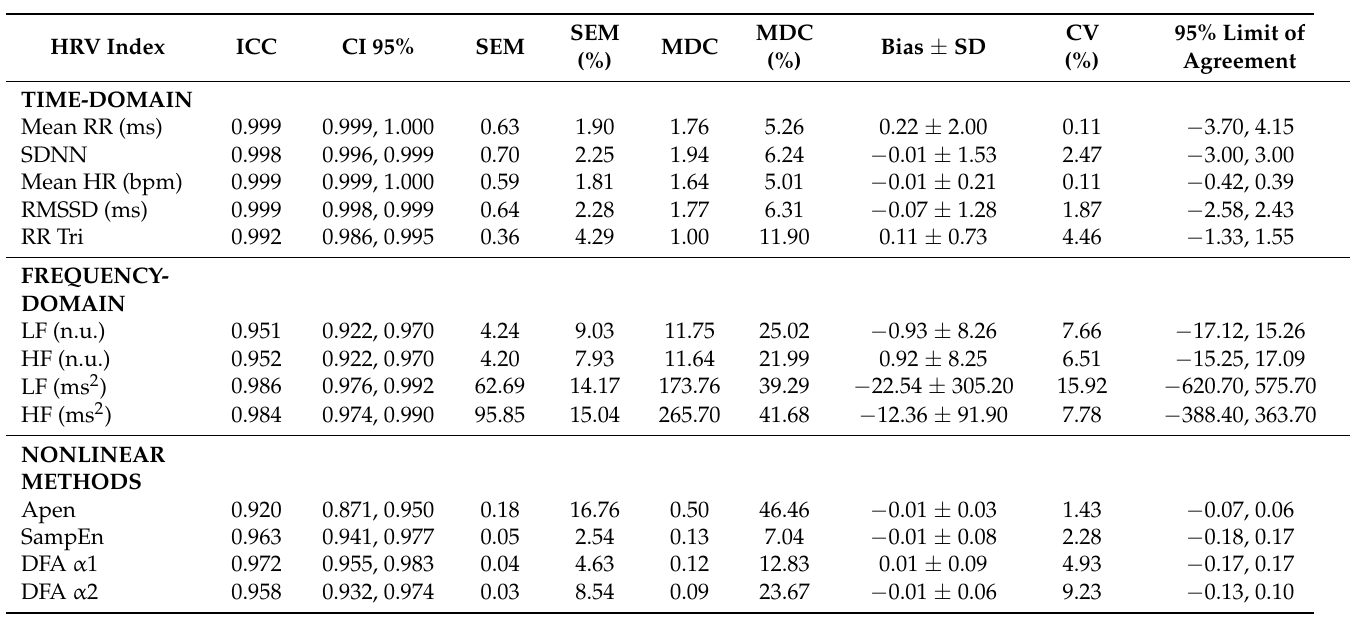
Table 3. Intrarater reliability of HRV analysis of post-COVID-19 individuals in the supine position (Researcher